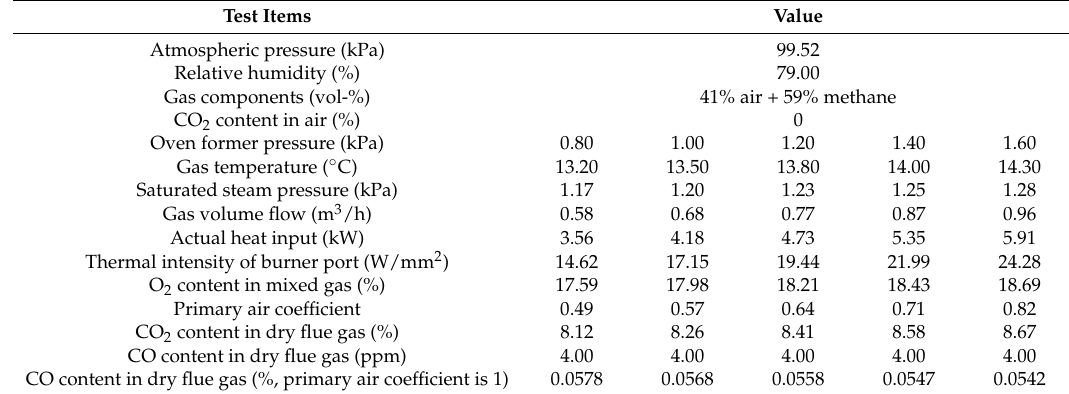
Table 8. Testing data of CO content in the flue gas of the comparative